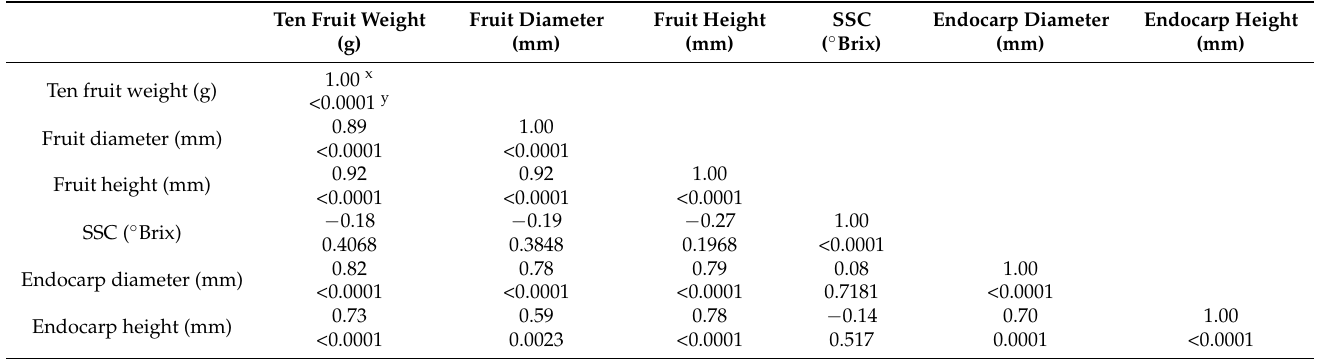
Table 5. Multivariate analysis of fruit and endocarp characteristics of Prunus serotina subsp. capuli genotypes, collected in the Andes region of Ecuador in 2016.